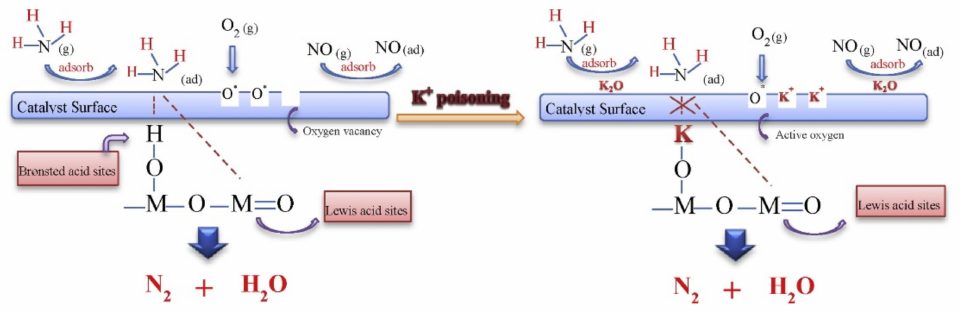
Figure 6. K + poisoning process of the catalyst. Reproduced with permission from Reference [82]; copyright (2014), Elsevier.